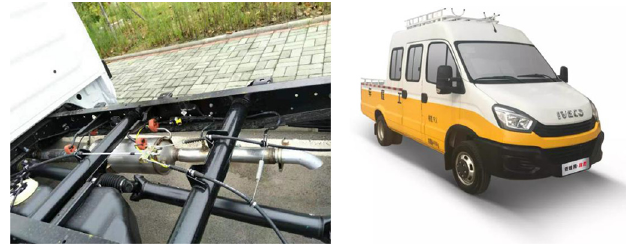
Fig. 22. The layout of the after-treatment system on a vehicle.